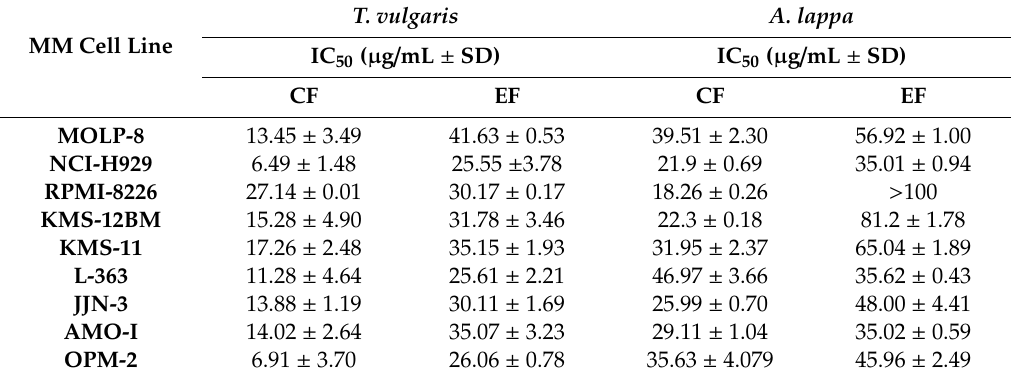
Table 3. Cytotoxicity of chloroform and ethyl acetate fractions of T. vulgaris and A. lappa towards MM cell lines as determined by the resazurin assay.